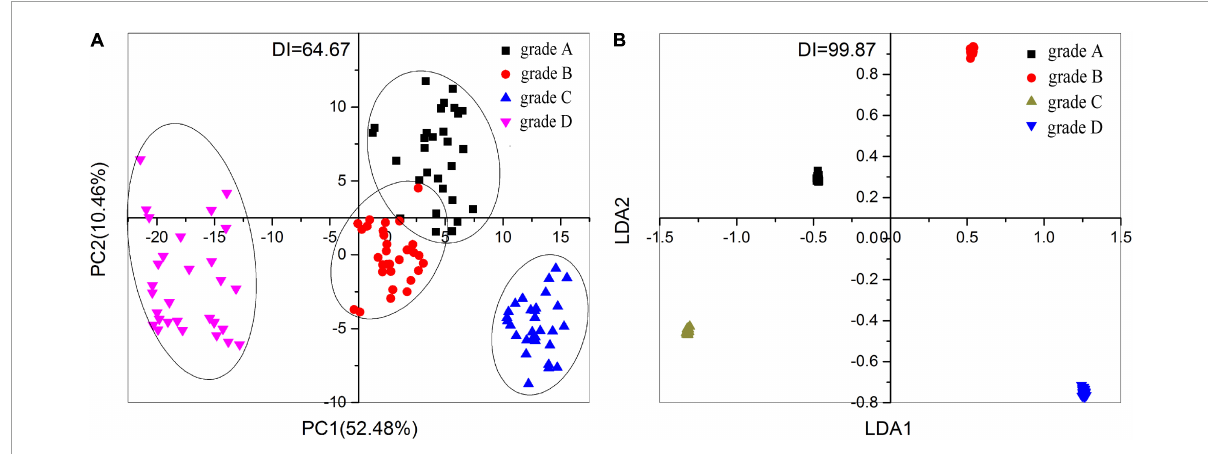
FIGURE1 Multivariate statistical analysis based on the result of the Smartongue analysis: loading plot of (A) principal component analysis (PCA) and (B) discriminant function analysis (DFA) for the classification of 120 strong-aroma types of base Baijiu (base SAB) samples from four different grades.